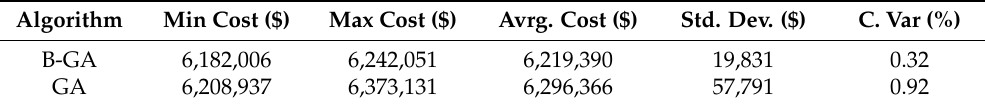
Table 5. Solutions found by both algorithms for the Hanoi